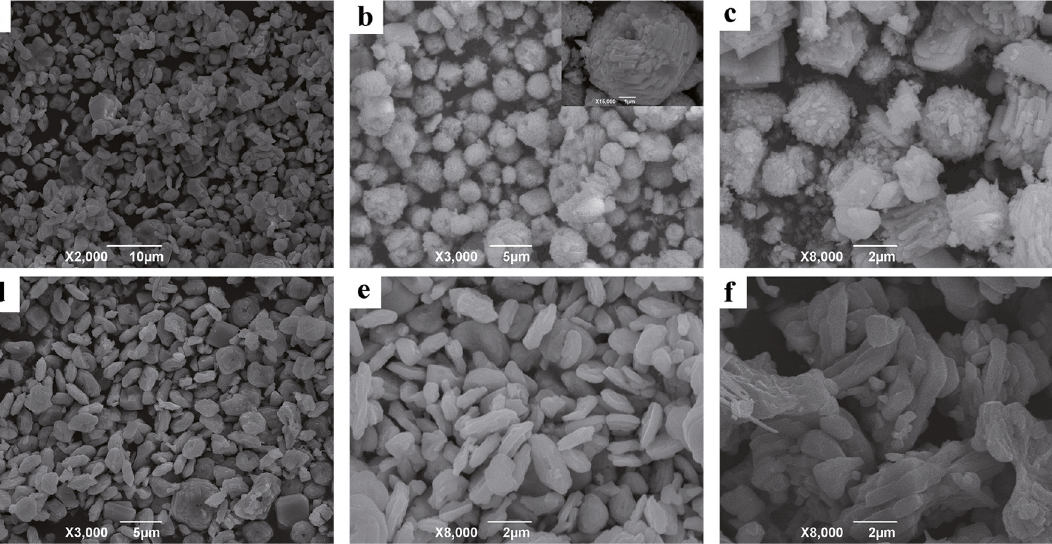
products obtained at pH=5 for 24 h under different hydrothermal temperatures. (a) 50 o C, (b) 70 o C, Figure 2: SEM images of CdMoO 4 (c) 80 o C, (d) 100 o C, (e) 140 o C, and (f) 180 o